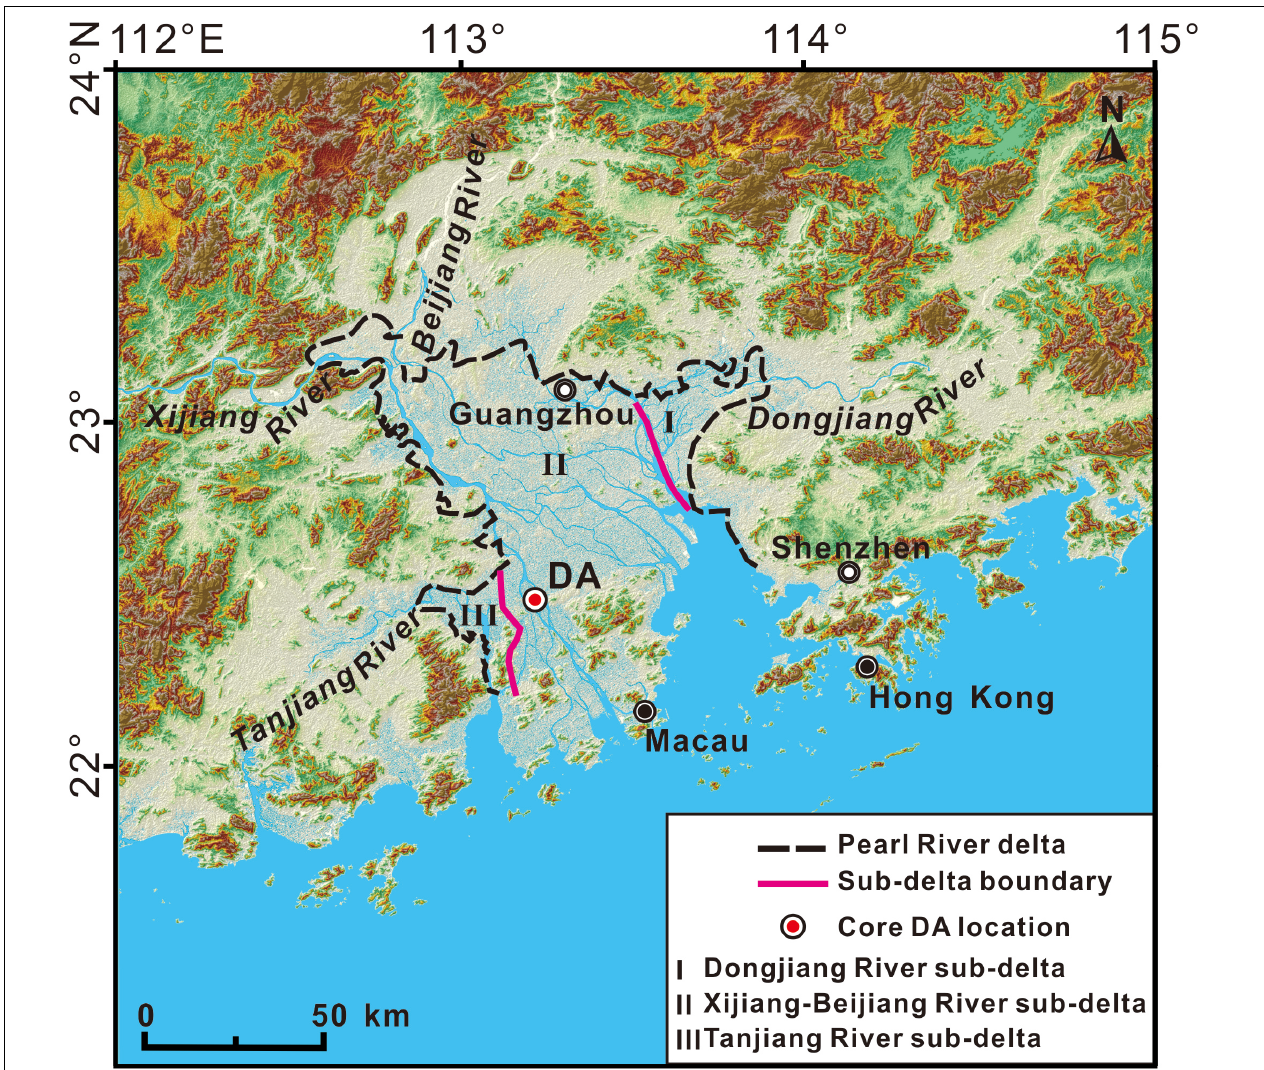
FIGURE 1 | Topographic characteristics of the Pearl River delta (PRD) and location of core DA. The PRD can be divided into Dongjiang River sub-delta (zone I), Xijiang-Beijiang River sub-delta (zone II) and Tanjiang River sub-delta (zone III). Core DA is located in the south of zone